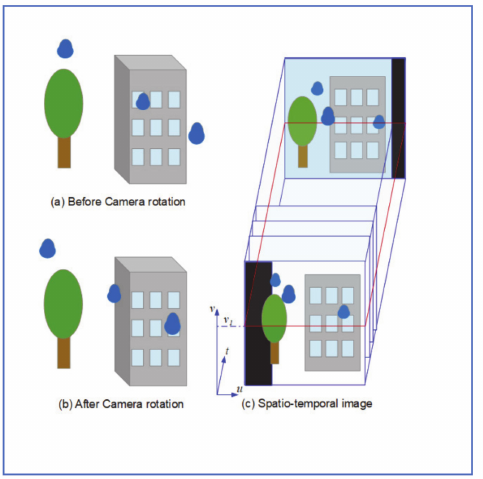
Figure 14. Stacking images in chronological order to generate cross-section image S ( u, t ) [33]. 1- Cross-sectional image S ( u, t ) = I ( u , v 1 , t ) is taken of the image stack at level v 1 . As shown in Figure 15, trajectories of a stationary object in S ( u, t ) are straight